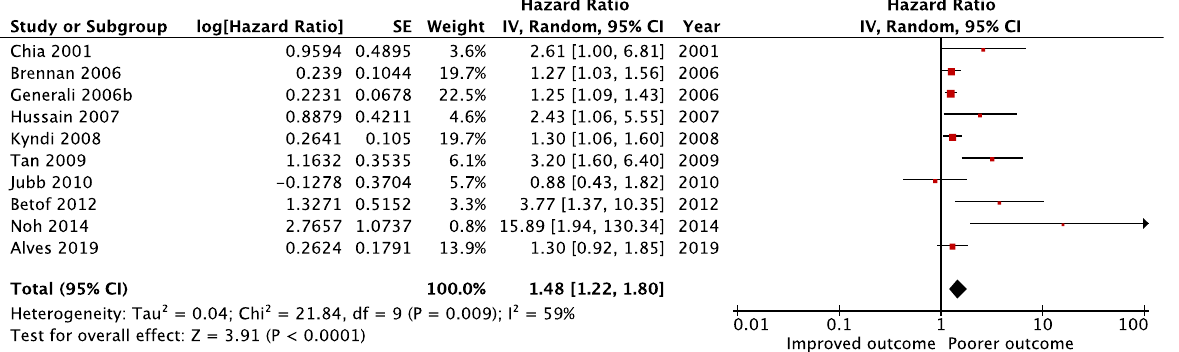
Fig. 4 Forest plot for the relationship between CAIX expression and overall survival in breast cancer